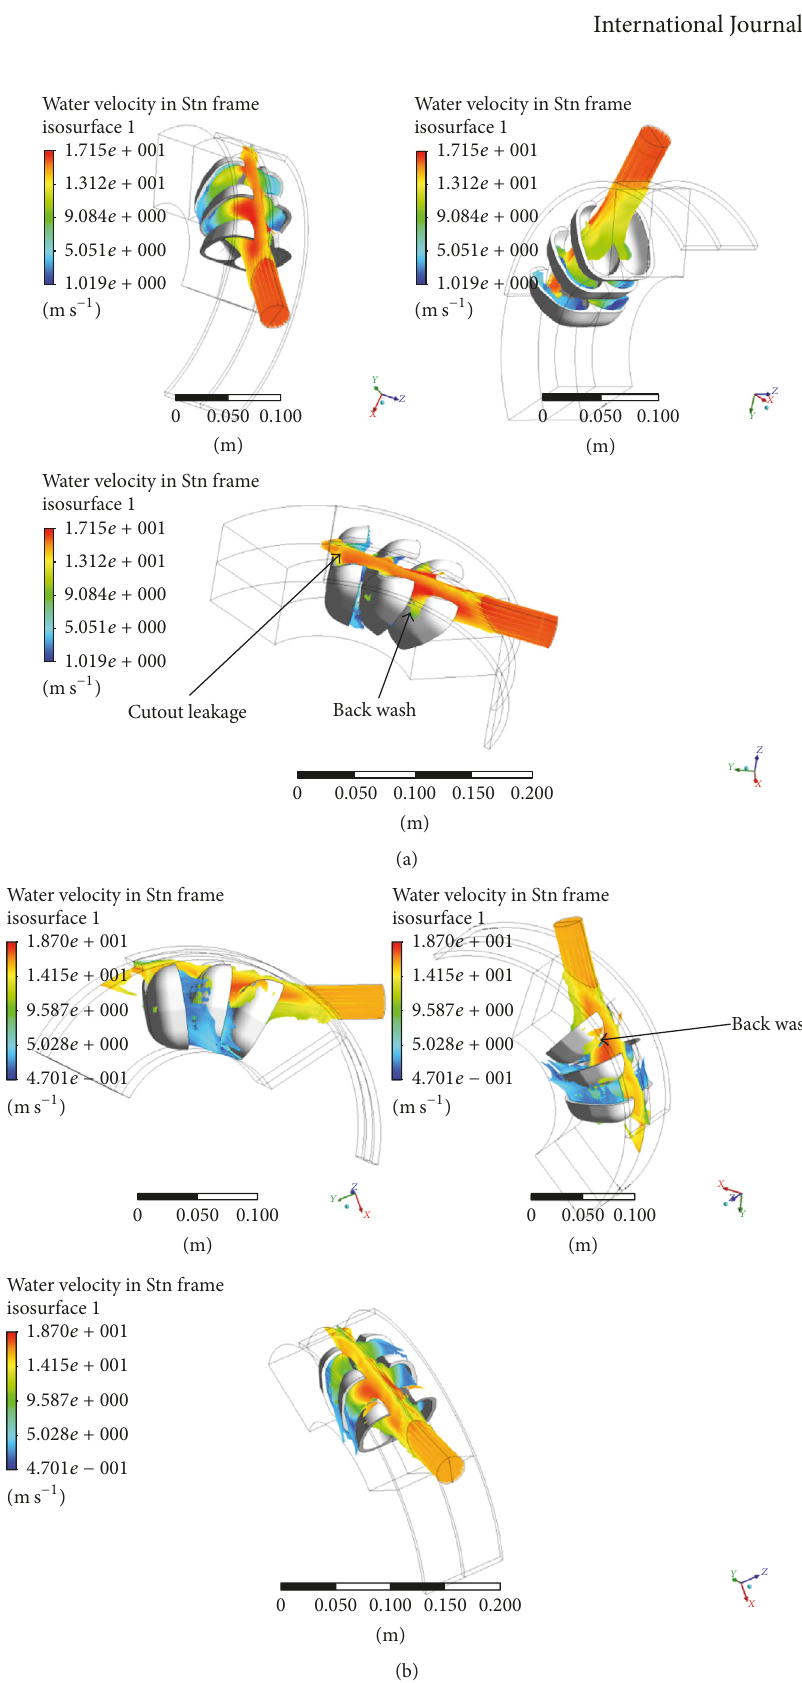
Figure 13: Flow distribution of the runner: water velocity in Stn frame, side views, and face views (PCD = 400